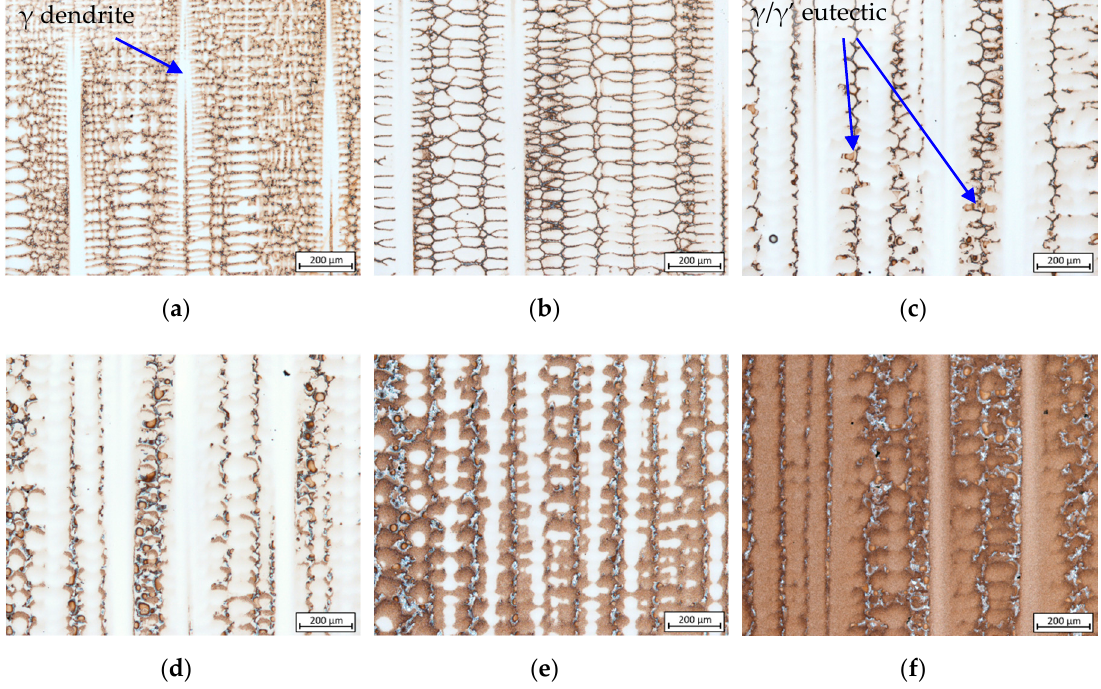
Figure 2. Microstructure evolution observed during preliminary analysis of CMSX-6 (W4) in sequence the ( a–e ) mushy zone from dendrite tip to ( f ) solidified single crystal. The lower crystallization temperature of γ matrix compared to prior studies might be caused